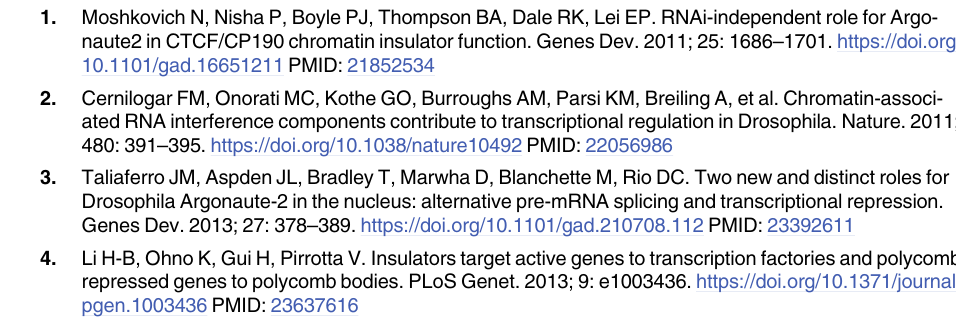
S4 Table. Antibodies used in this study. S5 Table. Oligos used in this